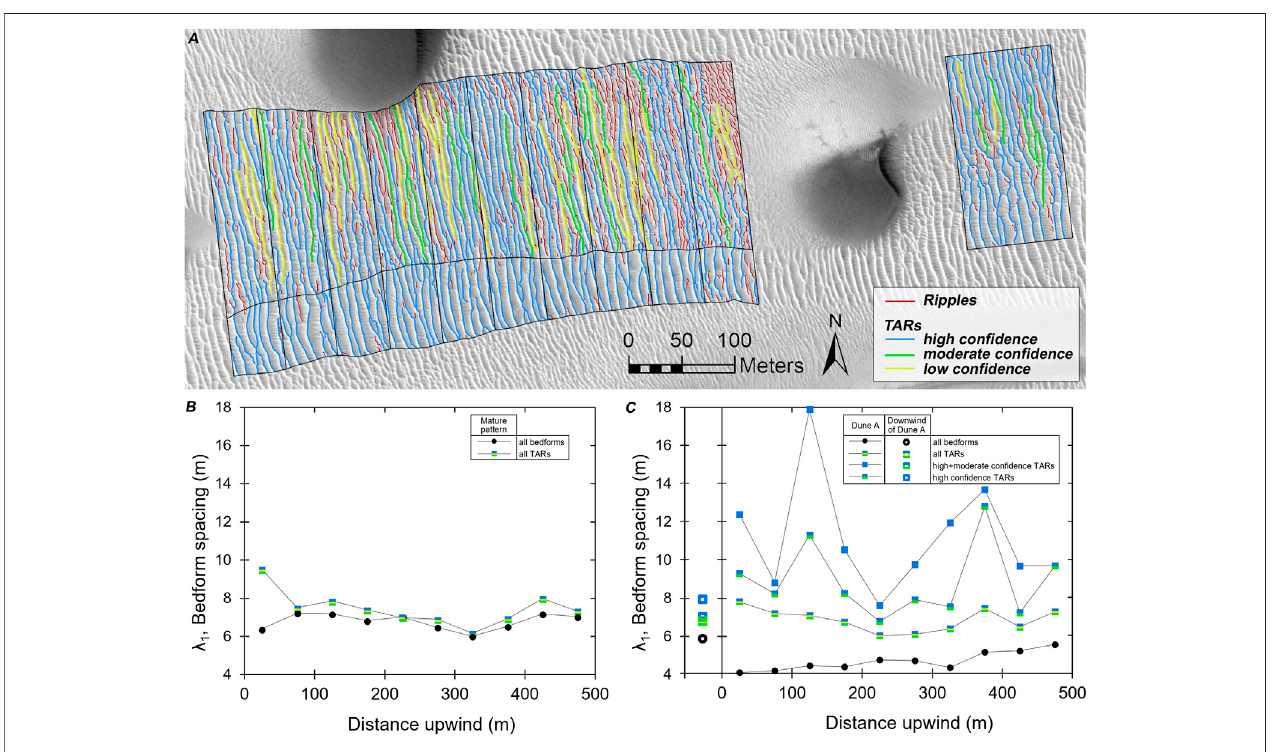
FIGURE6 |(A) TARs and ripples identi fi ed in theDuneAwake, downwind region and inthe mature pattern (orthorecti fi ed HiRISE image ESP_044722_2570). The variation of bedform and TAR spacing with distance upwind in the (B) mature pattern and the (C) wake indicate that the TAR spacing in each area is fairly constant, suggesting that the passage of Dune A did not strongly affect the TAR pattern in the